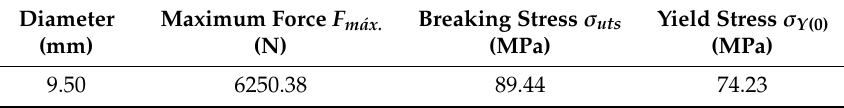
Table 2. Mechanical properties of the Ø 9.43 mm EN AW-1370 aluminium rod-wire.